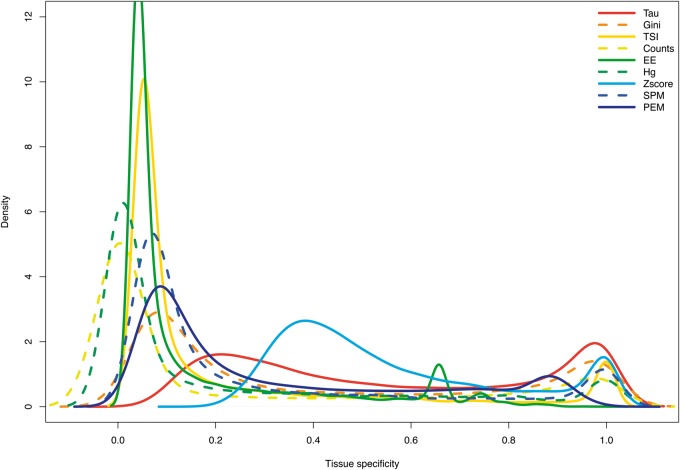
Distribution of tissue-specificity parameters with data for human RNA-seq of 27 tissues. Graph created with density function from R, which computes kernel density estimates. A colour version of this figure is available at BIB online: https://academic.oup.com/bib.